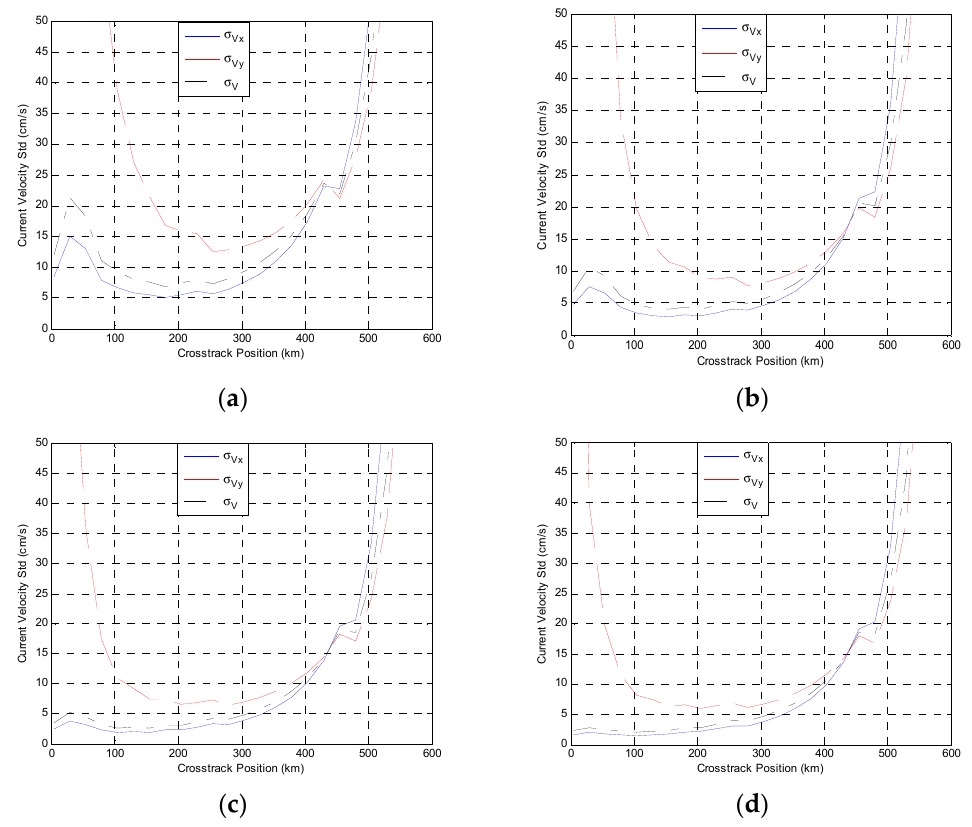
Figure 17. Surface current velocity components Std in line-of-sight, cross-track, and along-track directions with a wind direction of 90°: ( a ) U = 4 m/s; ( b ) U = 7 m/s; ( c ) U = 14 m/s; ( d ) U = 21 m/s.